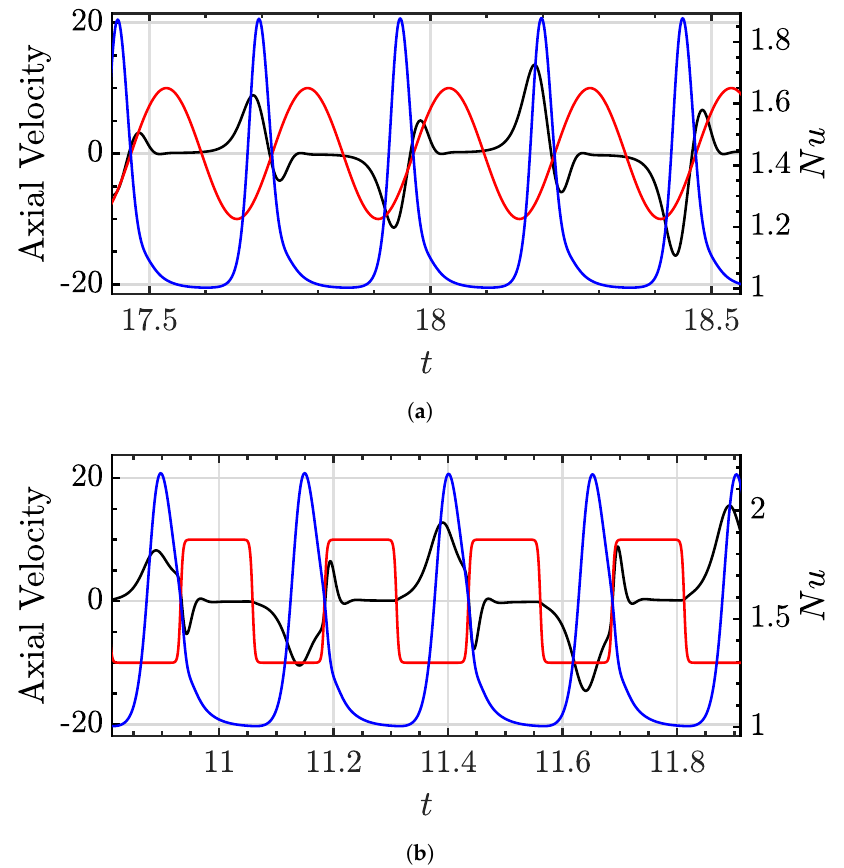
Figure 2. Time evolution of the Axial velocity (probe being located in the center of the layer), and Nusselt number. Numerical simulation with AR = 15, Pr g = 8, Ω = 25, ξ = 0.5, ϑ = 0.1, and Ra ω = 4000. ( a ) Sinusoidal and ( b ) pulse waves. In black ( — ) is represented the axial velocity, in blue ( — ) Nu ( t ) , and in red ( — ) the qualitative evolution of h ( t )